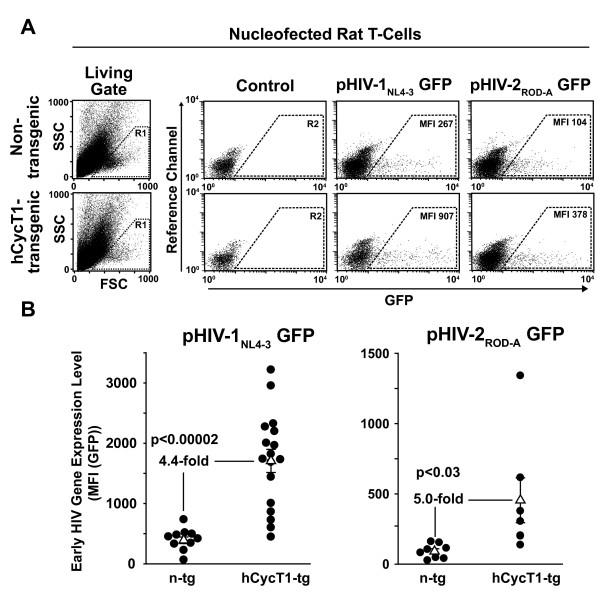
Enhanced early HIV-1NL4-3 and HIV-2ROD-A gene expression in primary T-cells from hCycT1-tg rats after nucleofection of proviral DNA. Activated T-cells from hCycT1-tg and n-tg rats were nucleofected with proviral GFP reporter constructs pHIV-1NL4-3 GFP or pHIV-2ROD-A GFP in principle as reported [3,27]. The GFP expression level in viable cells was analyzed 24 h later by flow cytometry. (A) Representative flow cytometry dot plots of nucleofected T-cells. Living cells were identified by their forward scatter (FSC) and side scatter (SSC) characteristics (left panels, R1 gate). The GFP fluorescence in living cells was analyzed against an empty reference channel (right panels, FL-4). The MFI of GFP-expressing cells (right panels, R2 gate) was determined as a surrogate marker for early viral gene expression. (B) Cumulative results from several independent experiments. Each closed circle depicts the MFI of provirus-nucleofected T-cells as the mean of triplicates performed for cultures from individual animals. Open triangles represent the arithmetic mean of the MFI of all animals in one group ± SEM. The indicated p-values were calculated using the unpaired Student's t-test.